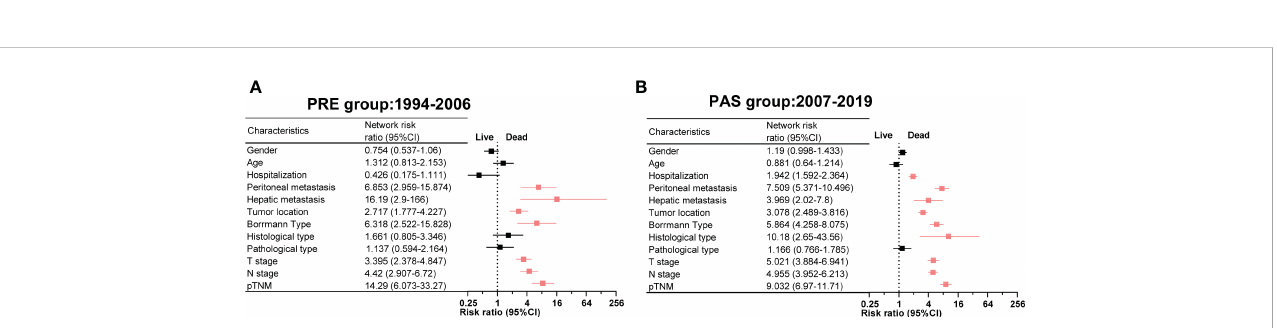
FIGURE 5 The relative risk of death and clinicopathologic features in the PRE group (A) and the PAS group (B) . Symbols and error bars: black, P > 0.05; red, P < 0.05 and RR